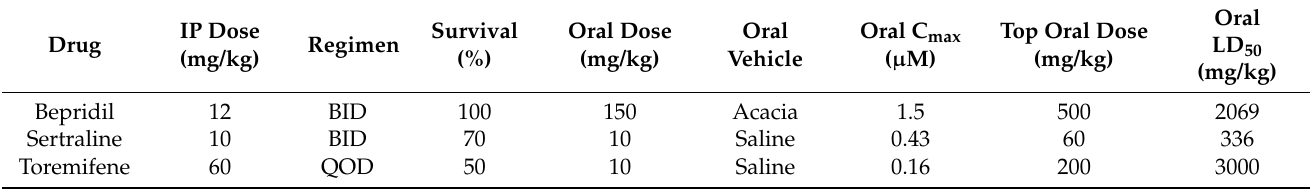
Table 2. Rationale for choice of top oral